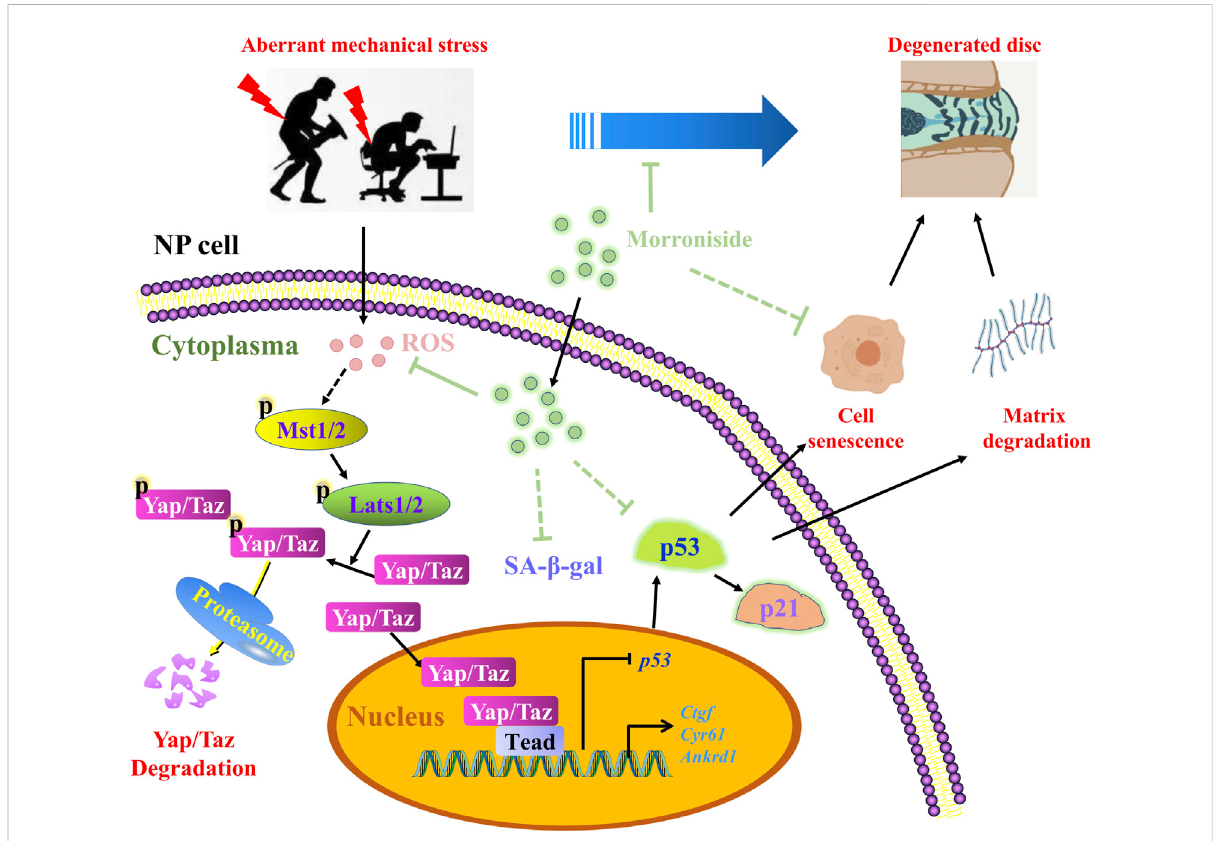
FIGURE 6 The schematic working model of MR-mediated protection against NP cell senescence and IVDD progression by targeting the ROS-Hippo- p53